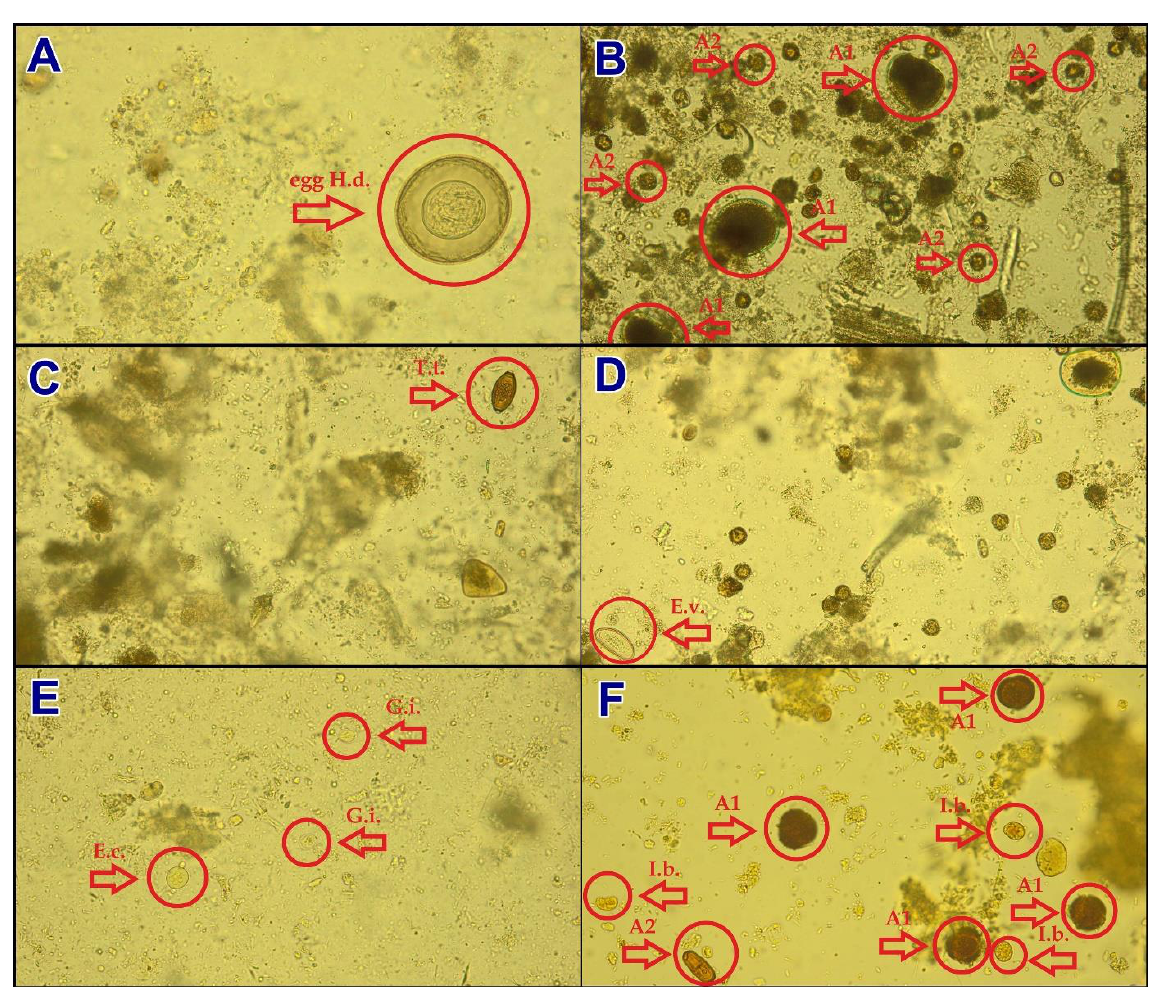
Figure 2. Photographs of microscopic preparations used in the study (diagnostic elements have been marked with a red arrow and a circle). A. Hymenolepis diminuta (H.d.), embryonated egg in faeces (400× magnification); B. Artefacts (A1, A2), pseudo-parasites (200× magnification); C. Trichuris trichiura (T.t.), unembryonated egg in faeces (200× magnification); D. Enterobius vermicularis (E.v.), egg in faeces (200× magnification); E. Giardia intestinalis (G.i.) and Entamoeba sp. (E.c.), cysts in faeces (400× magnification); F. Iodamoeba bütschlii (I.b.), cysts and artefacts (A1, A2) in faeces (400× magnification).